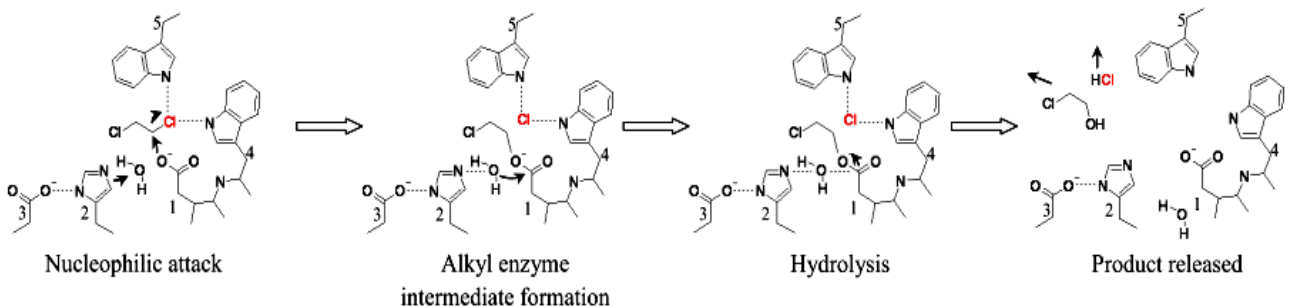
Fig. 2. Catalytic mechanism of HLDs. 1. nucleophilic aspartic acid, 2. histidine base, 3. glutamic/aspartic acid, 4. first halide stabilizing residue adjacent to nucleophilic, and 5. second halide stabilizing